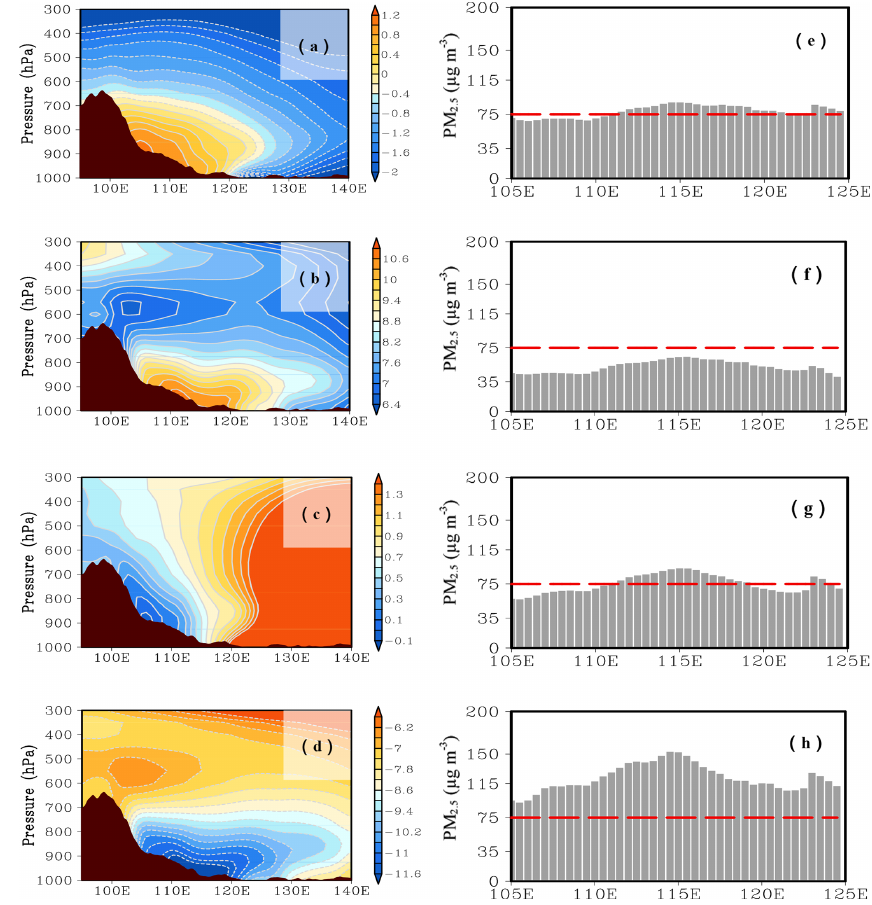
Figure 3. Vertical cross sections of (a–d) air temperature anomalies (unit: ◦ C) and (e–h) the PM 2 . 5 concentrations (unit: µgm − 3 ) averaged along 25–40 ◦ N in spring (a, e) , summer (b, f) , autumn (c, g) and winter (d, h) from 2013 to